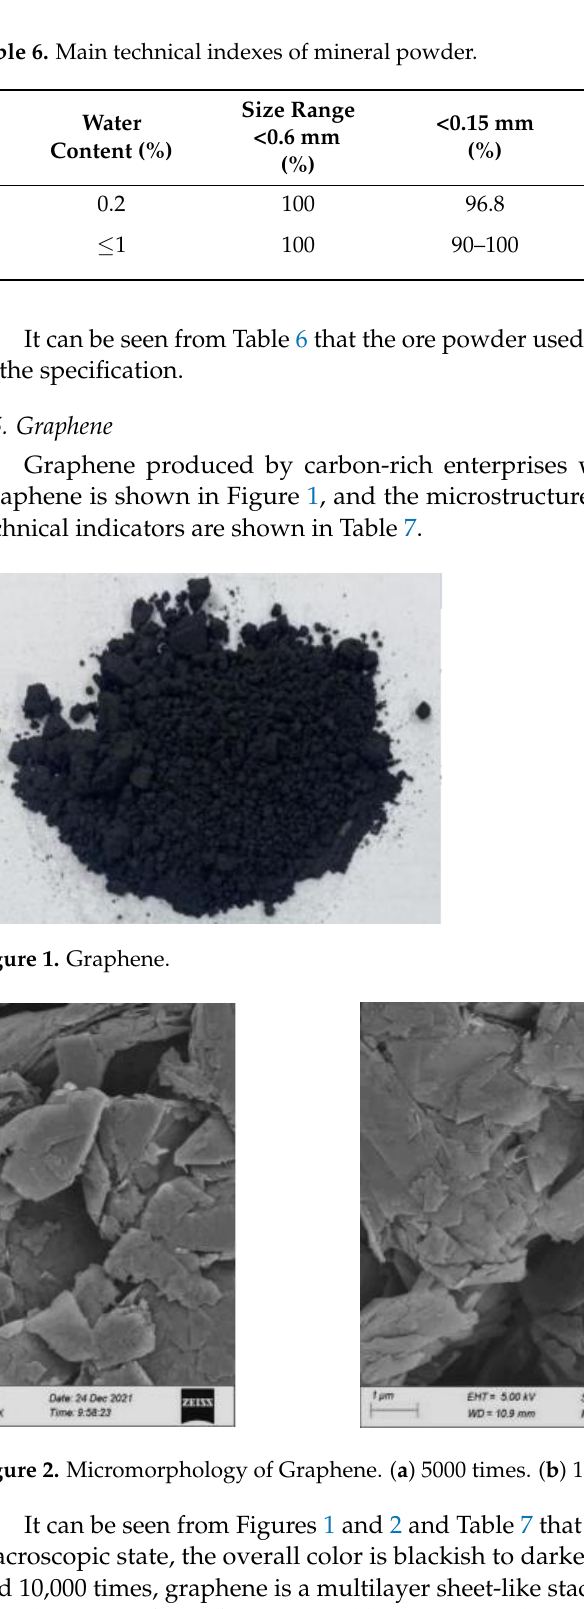
Table 7. Technical specifications of graphene.